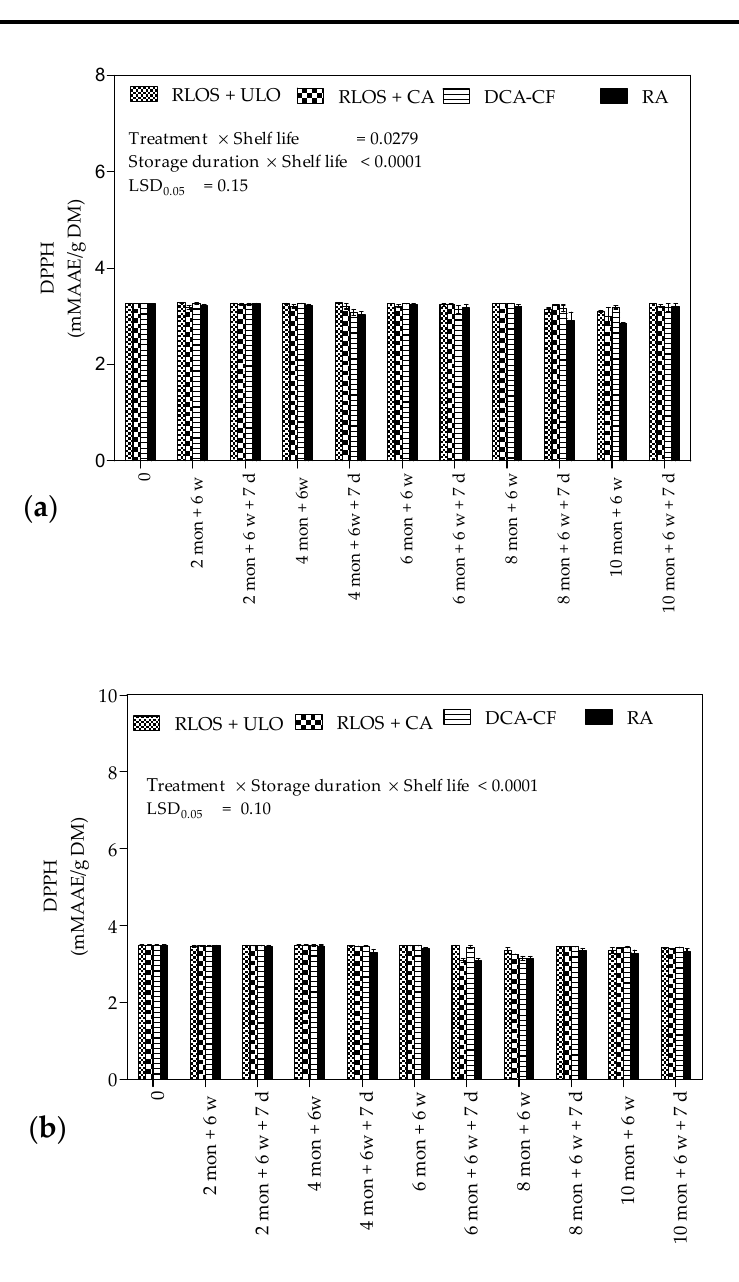
Figure 9. Radical scavenging activity (mgGAE/g DM) of ‘Granny Smith’ apples harvested in the 2015 ( a ) and 2016 ( b ) seasons at commercial maturity and stored for up to 10 months at 0 °C in various storage conditions, evaluated every two months followed by a 6 week simulated shipment and handling period, and at 7 days on the shelf (20 °C and 65% RH). Vertical bars represents the standard error (SE) of mean values of 3 replicates (1 replicate = 10 fruit). LSD 0.05 represent least significant difference ( p < 0.05). For storage duration, mon—months; w—weeks; and d—days.